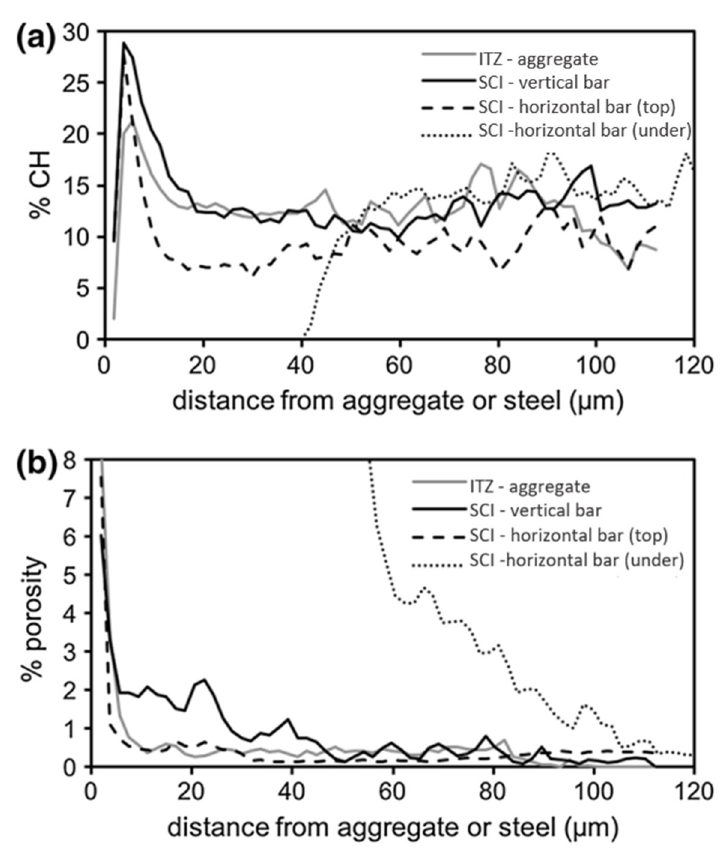
Figure 2. At the ITZ and SCI, ( a ) calcium hydroxide (CH) and ( b ) porosity percentage between steel rebar (9 mm) and cement. Duration 1-year w/c = 0.49 [23].